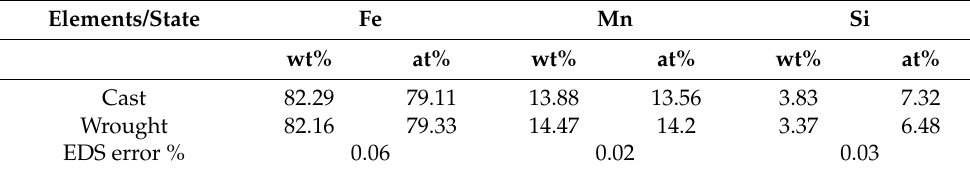
Table 1. Experimental results after chemical composition analysis for the initial cast sample and wrought state (average values after five determinations on different 1 mm 2